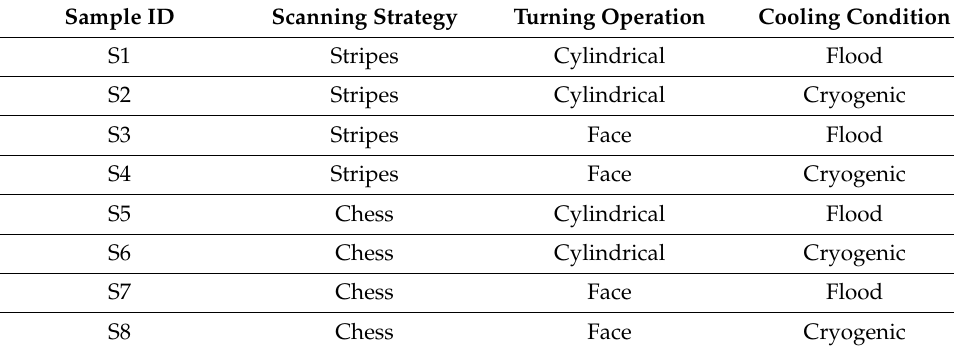
Table 2. Experimental plan for the machining